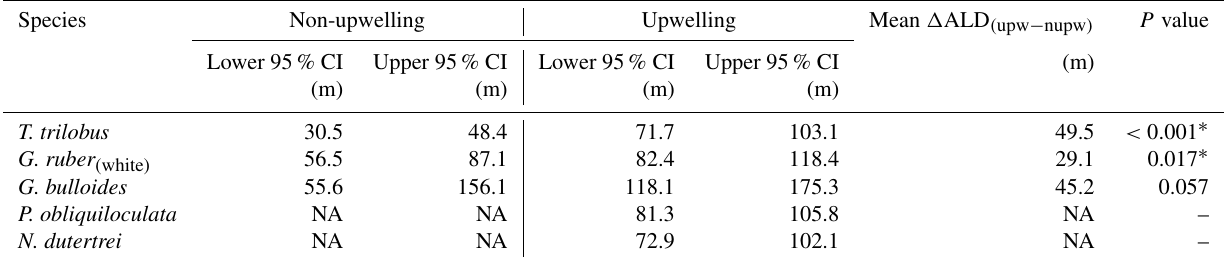
Table 1. The 95% confidence interval of the habitat depth of six species of planktic foraminifera in upwelling vs. non-upwelling regions. The upwelling region consists of transects 5–7, while the non-upwelling region consists of transects 1–3. Details of the calculation are described in the “Materials and methods” section. Species Non-upwelling